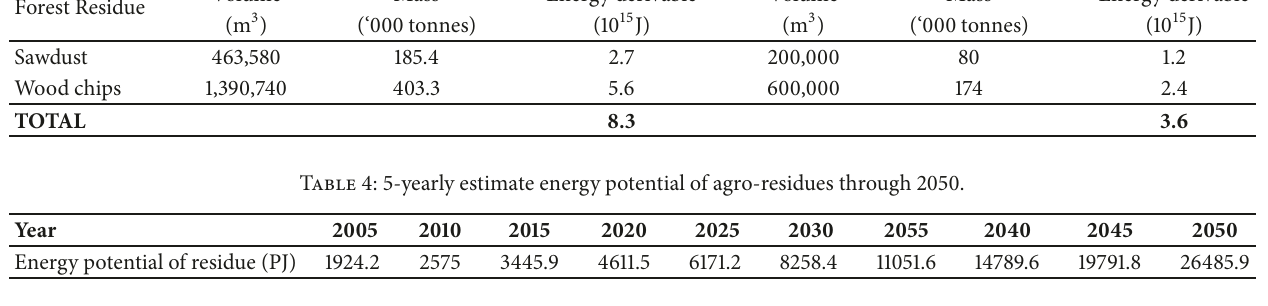
Table 5: 5-yearly potential of forest residues at 5.5% increase in production rate (10 15 J).